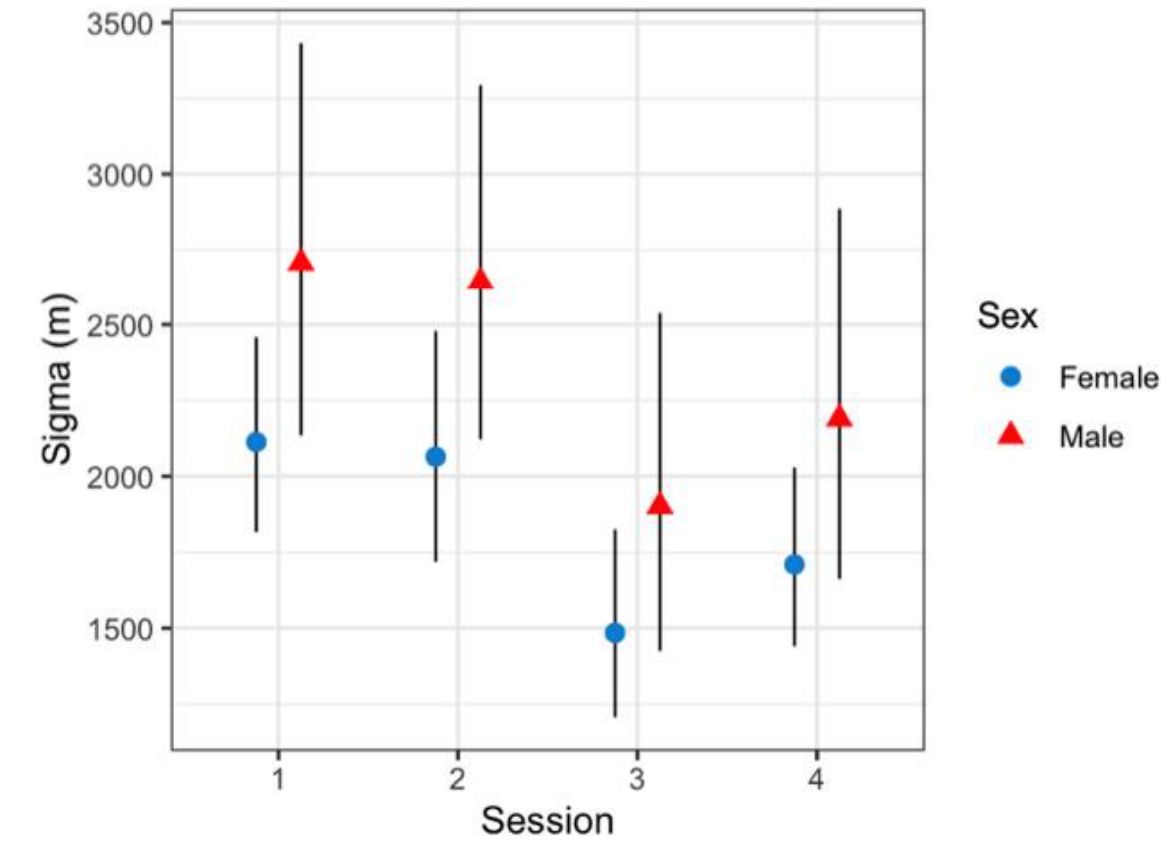
Figure 6. Sex-/season-specific effect on jaguar sigma (m) from top model structure in Sector Santa Rosa, Guanacaste Conservation Area, Northwestern Costa Rica. The black line represents 95% confidence intervals.